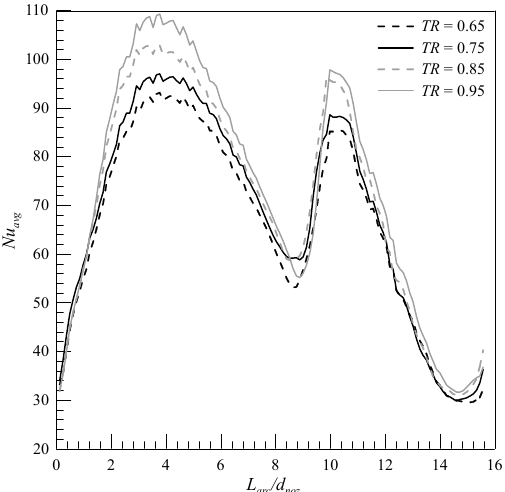
Figure 17. Spanwise average Nusselt number on the target surface of the compound cooling unit at different TR .